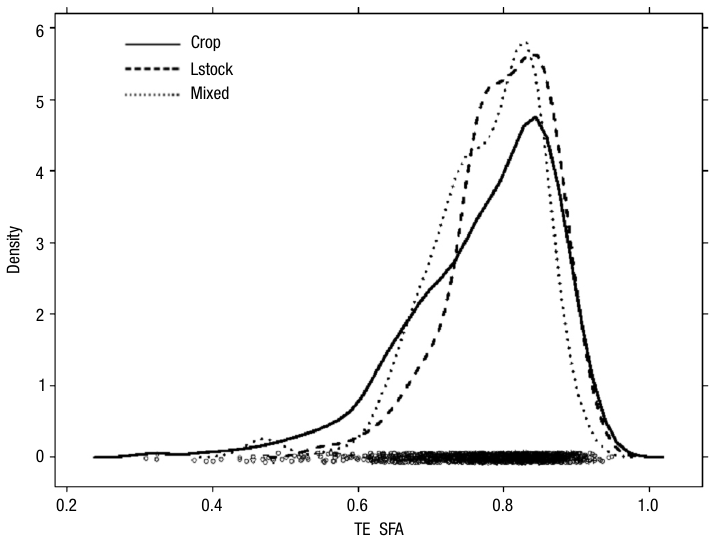
Fig. 2. Kernel densities of the TE scores across different farming types